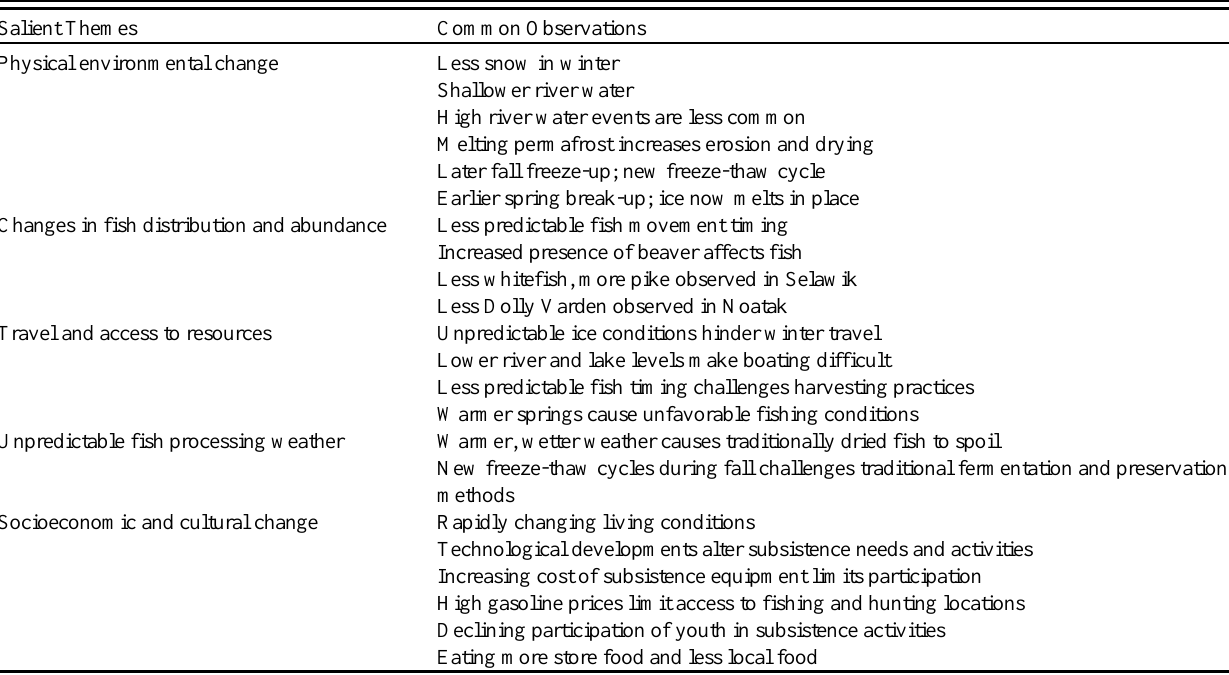
Table 1 . Common observations of a total environment of change as described by informants of Noatak and Selawik. Salient